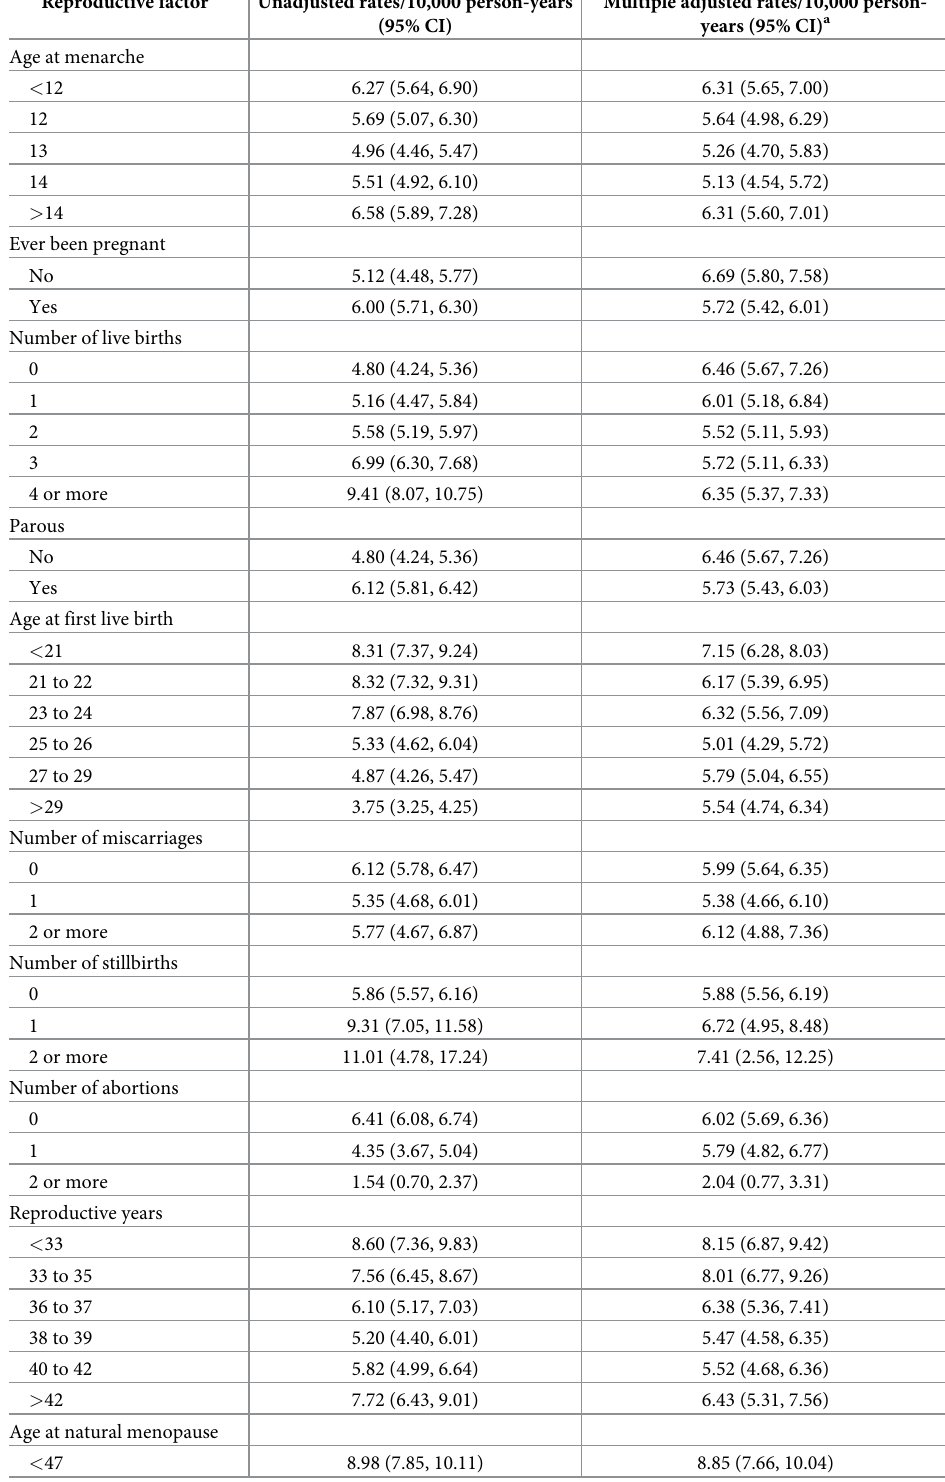
Table 2. Unadjusted and multiple adjusted rates of incident dementia for reproductive risk factors in